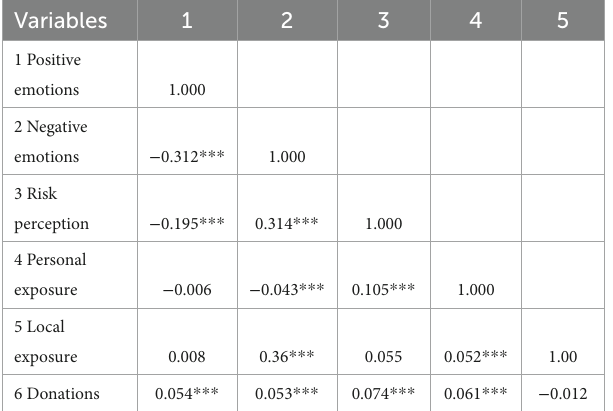
TABLE 3 The correlation analysis between key